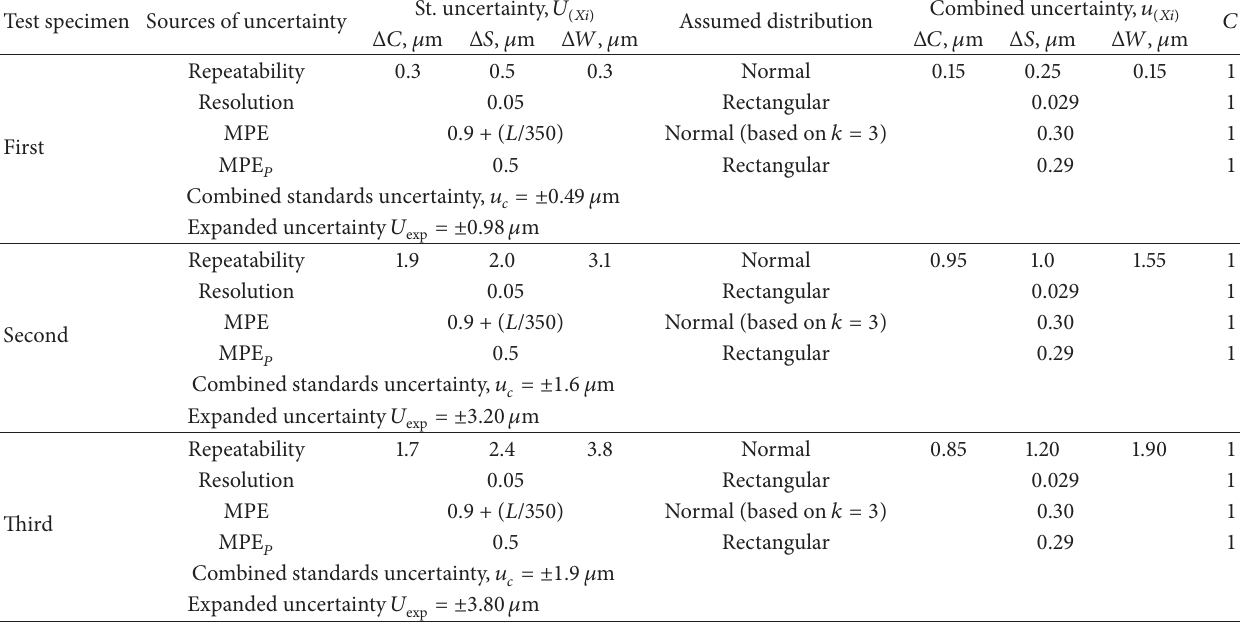
Table 6: Estimation of uncertainty budget in point deviation for tiles measurements.